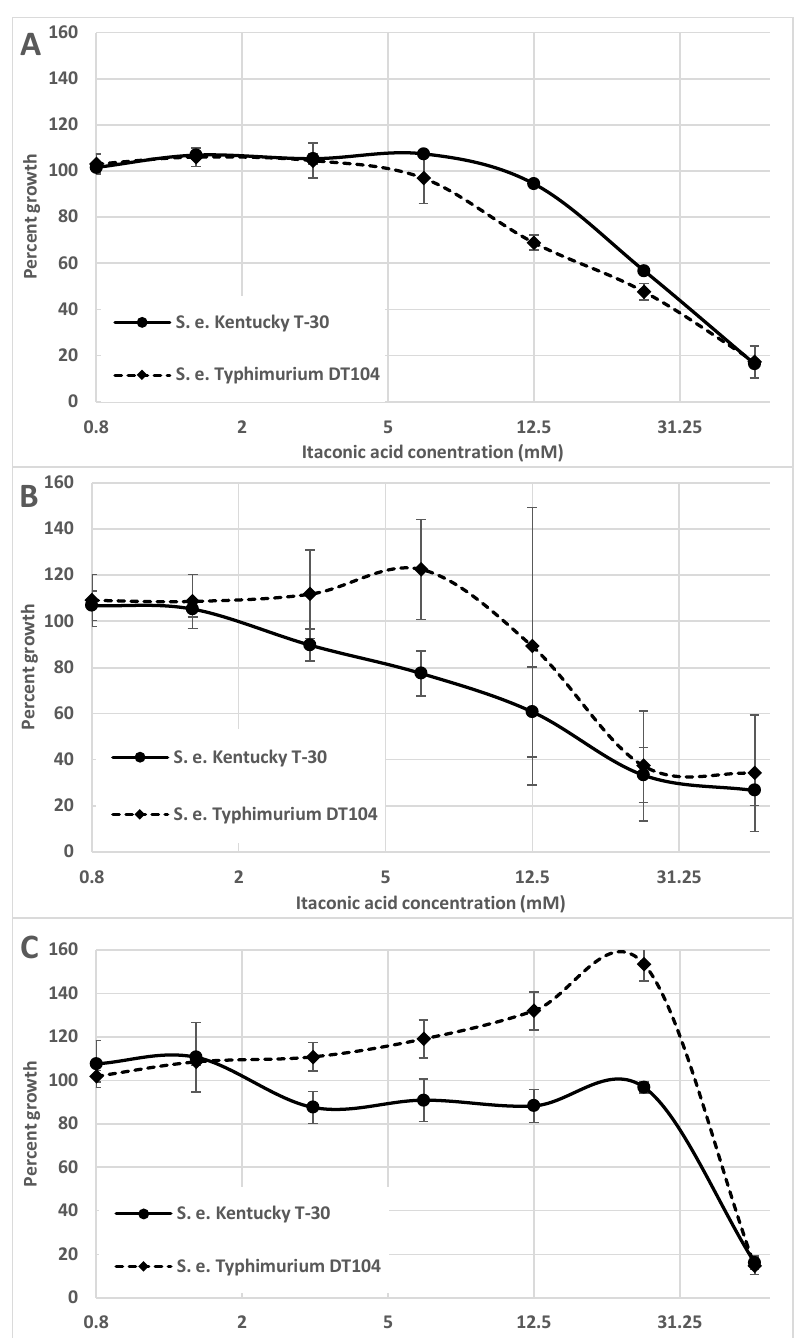
Figure 1. Percentage growth in M9 minimal medium containing various concentrations of itaconic acid, expressed as percentage of growth in the medium without itaconic acid. Cells were grown as described by Hammerer et al. [29]. ( A ) Growth percentages in M9 minimal medium containing 1% glucose. ( B ) Growth percentages in M9 minimal medium containing 0.4% acetate. ( C ) Growth percentages in M9 minimal medium containing 0.4% pyruvic acid. The pH of the M9 minimal media was adjusted to pH 6.8 prior to the addition of itaconic acid. Results are averages of six independent growth studies. The error bars indicate standard deviation. Student t -test analysis for the di ff erences in means indicated p -values of 0.035, < 0.001 and 0.079 for itaconic acid concentrations of 3.125, 6.25 and 12.5, respectively, for growth in acetate-containing medium and of < 0.001 for itaconic acid for itaconic acid concentrations of 3.125, 6.25, 12.5 and 25 mM for cells grown in medium with